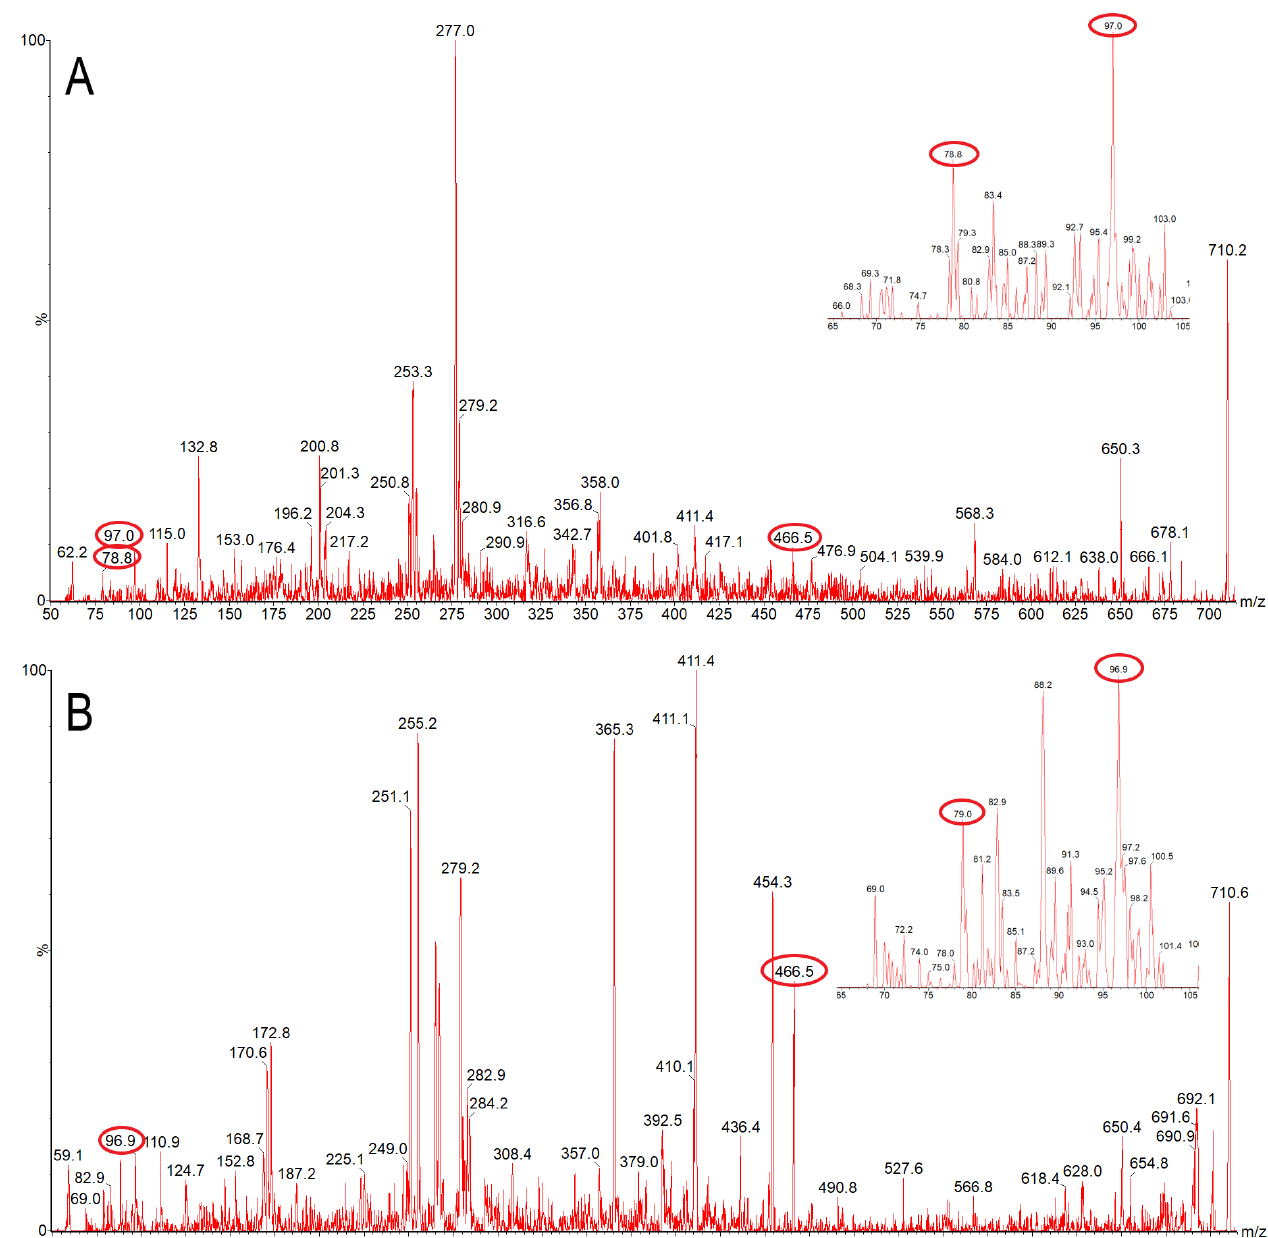
Figure 2. Product ion spectra of m/z 710.4, the m/z of the [M-H] − ion of lipid X. ( A ) Arabidopsis thaliana extract, ( B ) Chlorella cell wall fraction. Insets show the m/z range from 65 to 105. Fragments characteristic of lipid X are circled. Characteristic fragments include m/z 79, 97, 240, and 466, of which m/z 79, 97, and 466 were detected in both species.